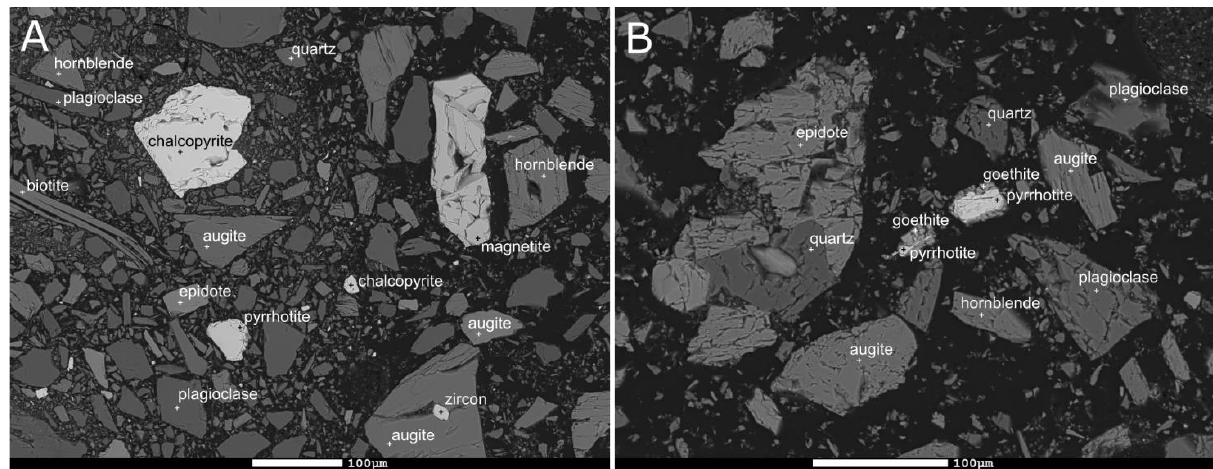
Figure 1. Backscattered electron images of the sample WR4 material before ( A ) and after ( B ) the HA2 extraction.